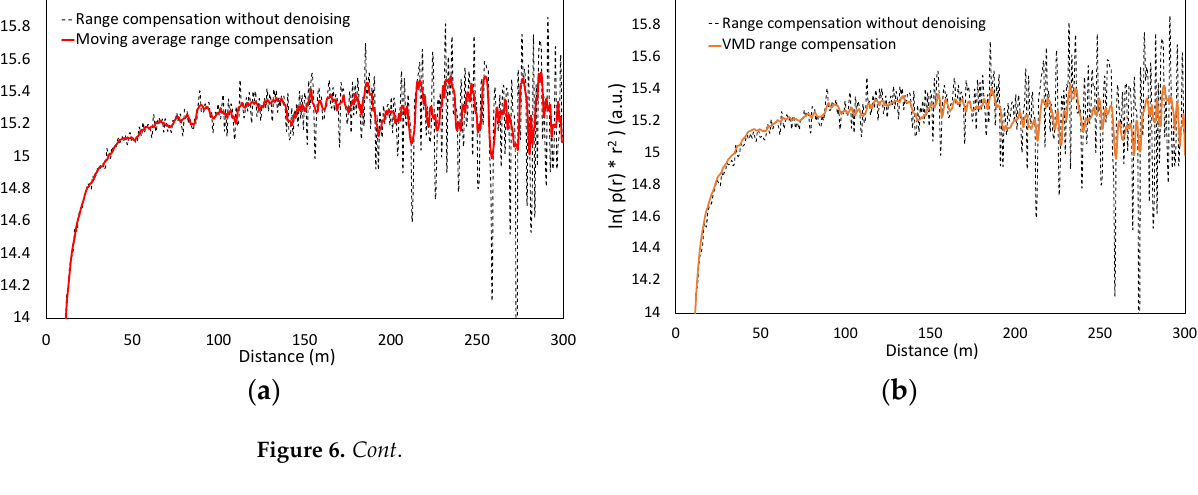
Table 1. Comparison of R-square and RMSE with the three denoising methods. Denoising Method R-Square RMSE Original echo 0.9421 Moving average